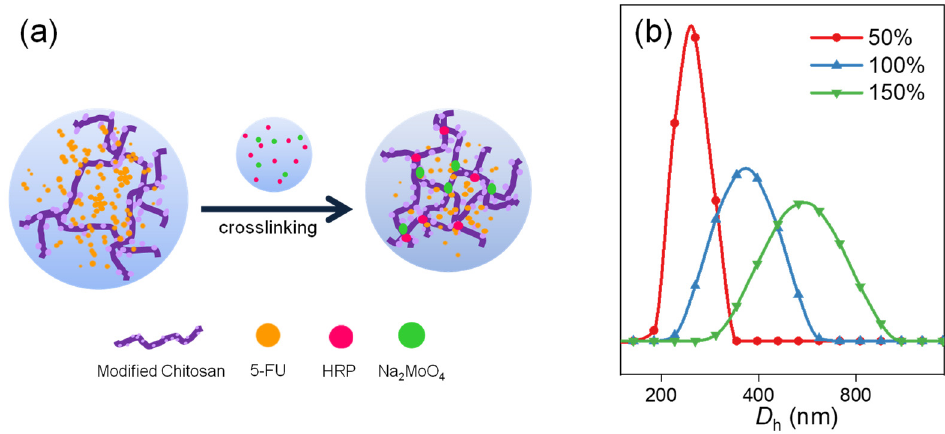
Figure 4. ( a ) Scheme of 5-FU loading in multiple-crosslinked nanogel; ( b ) Hydrodynamic diameter distributions of MC/M/H-B4 nanogels with different 5-FU dosages.